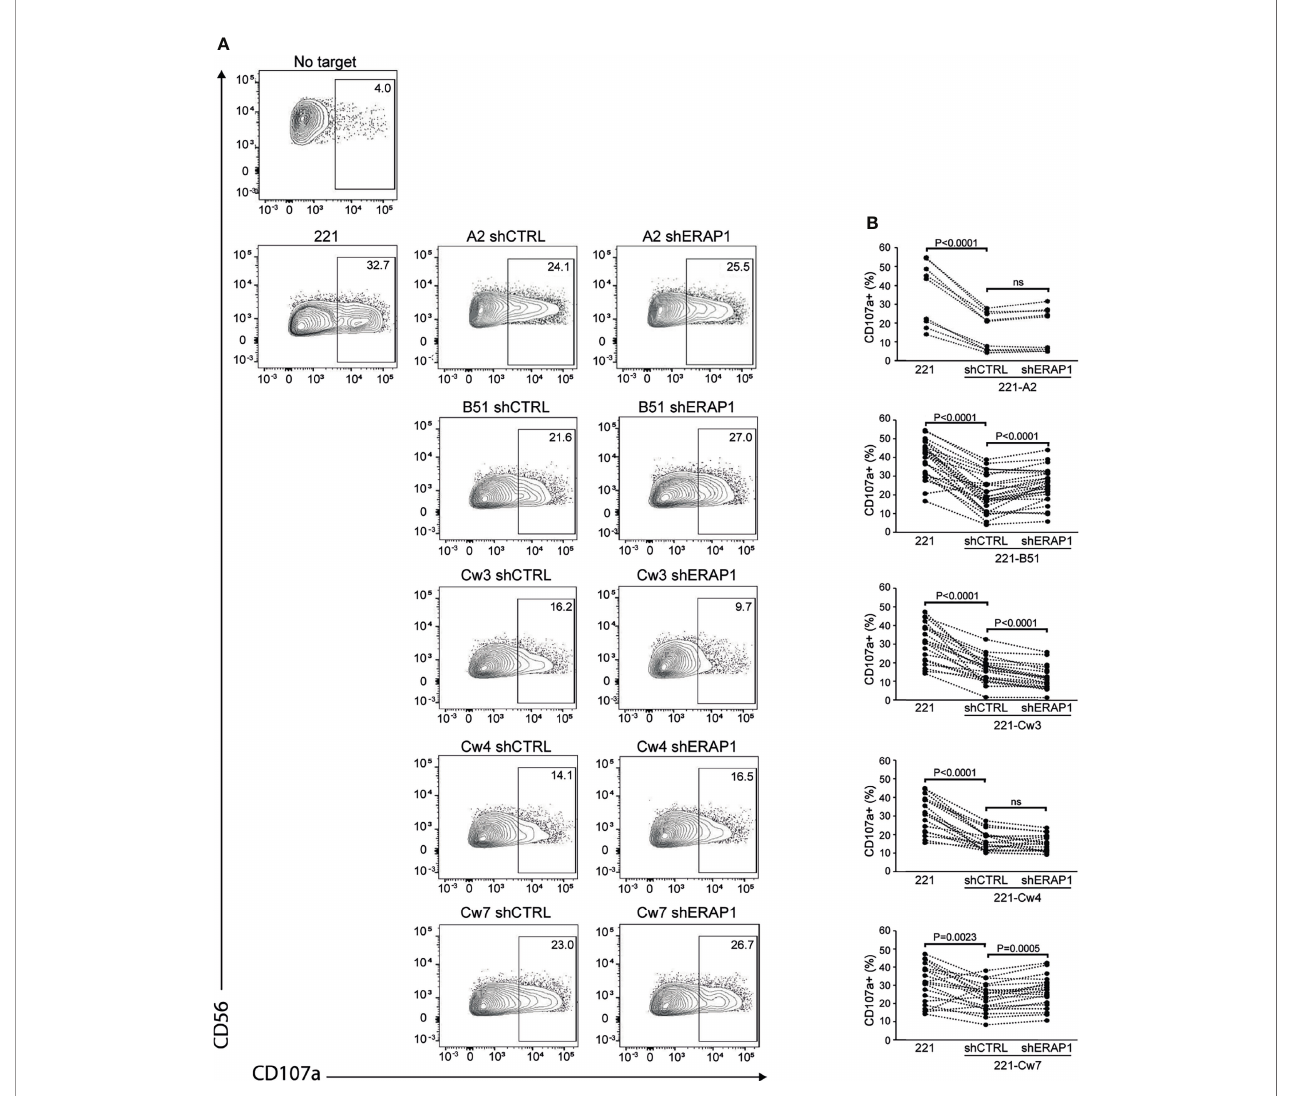
FIGURE 3 | Inhibition of ERAP1 enhances NK cell killing of 221-B*51:01 cells. (A) , Example of degranulation by human CD56 + NK cells from one healthy donor expressing KIR2DL1, KIR2DL3, and KIR3DL1 measured as CD107a cell surface expression in response to the indicated cells. The percentage of CD107a + cells within the indicated NK cell subsets is shown. (B) Summary of NK cell degranulation from donors after stimulation with 221 parental and transfectant cells in response to ERAP1 inhibition. P values, calculated by two-tailed paired Student ’ s t -test. ns, not signi fi